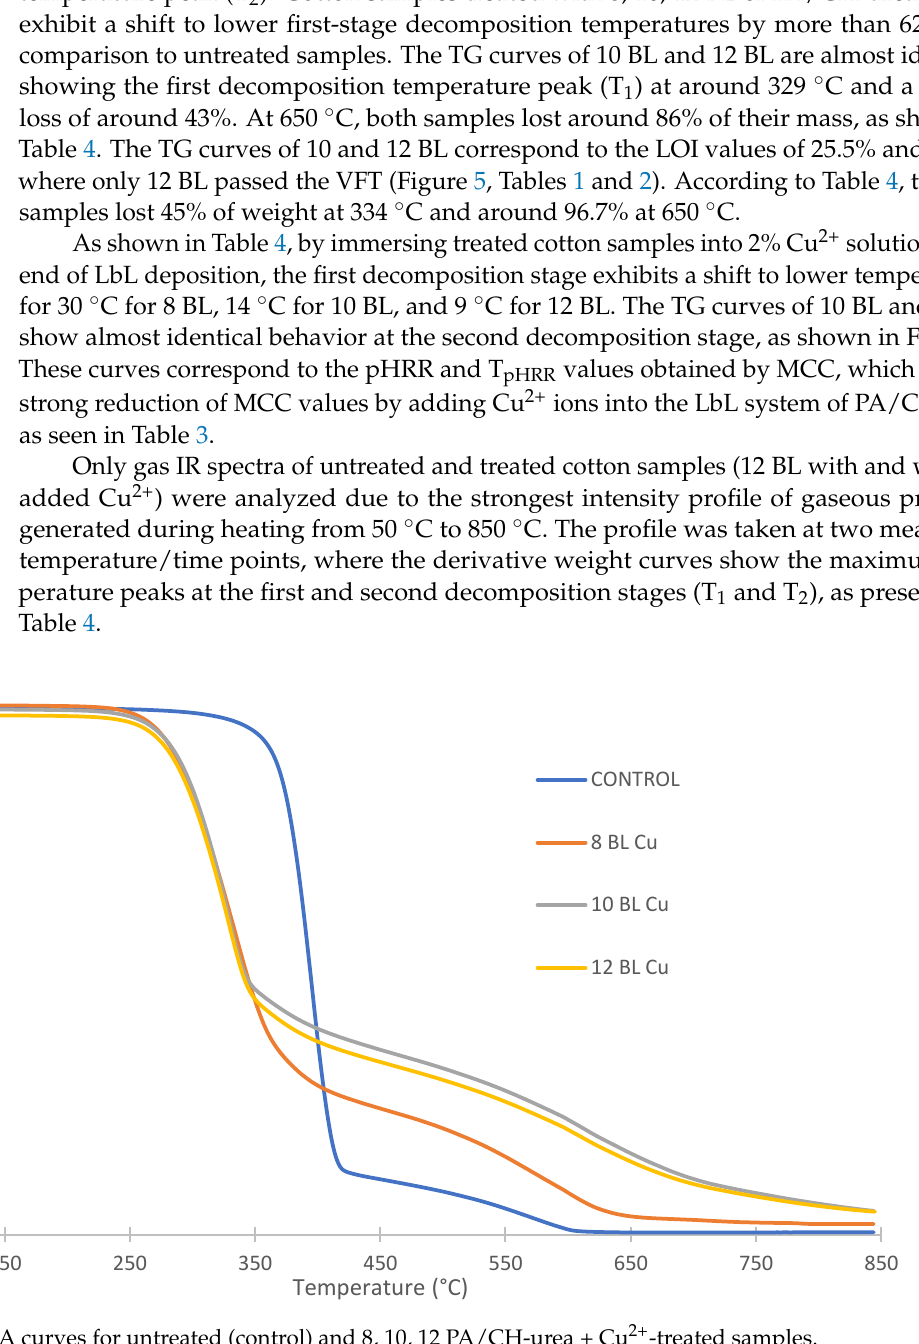
Figure 4. TGA curves for untreated (control) and 8, 10, 12 PA/CH-urea + Cu 2+ -treated samples. Only gas IR spectra of untreated and treated cotton samples (12 BL with and without added Cu 2+ ) were analyzed due to the strongest intensity profile of gaseous products generated during heating from 50 °C to 850 °C. The profile was taken at two measuring